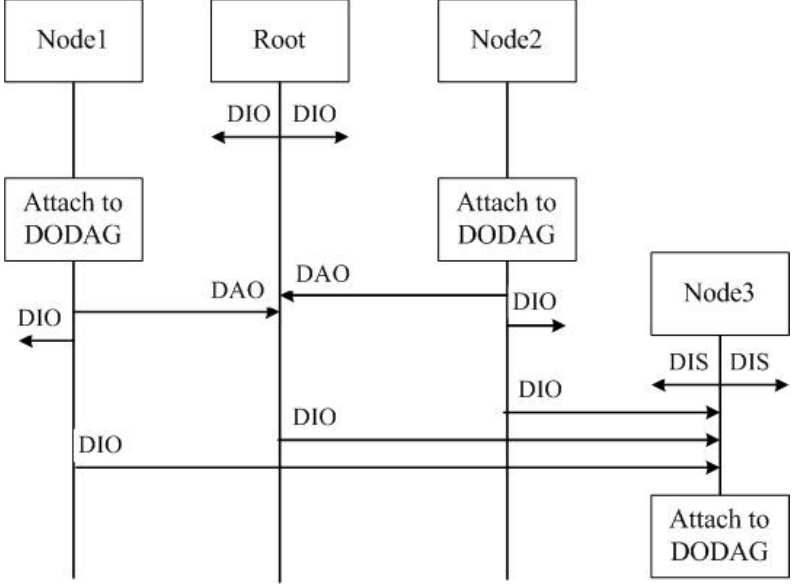
Figure 2. DODAG Construction process